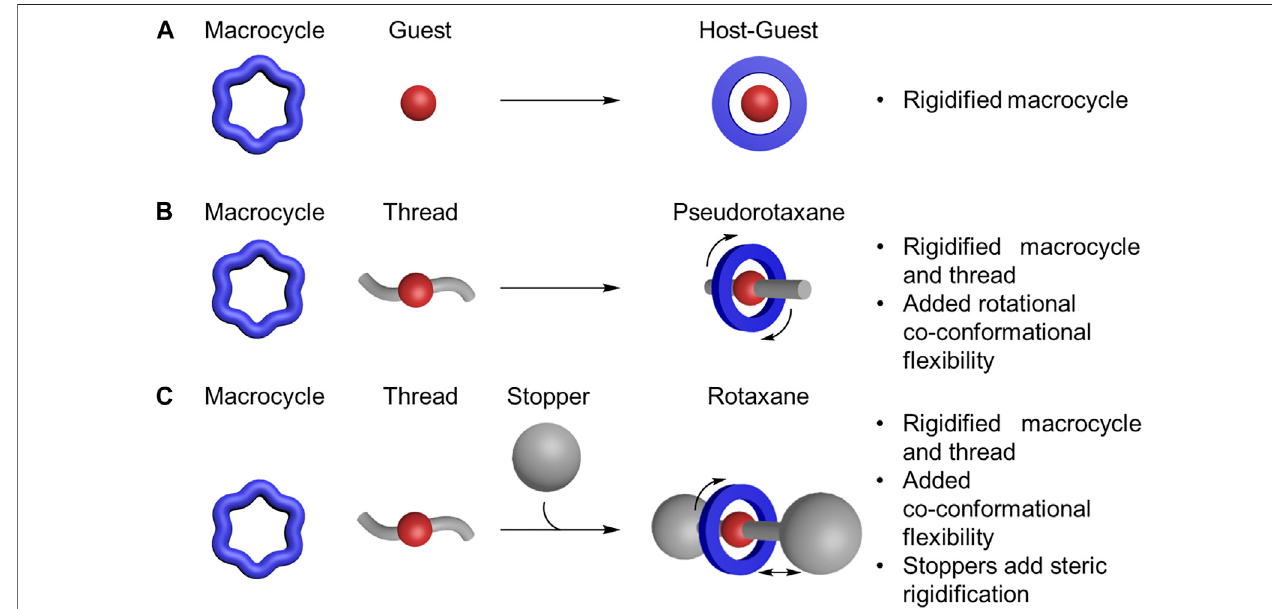
FIGURE 3 | Formation of (A) host-guest complex, (B) pseudorotaxane, and (C) rotaxane from macrocycles, guests, threads, and stoppers.